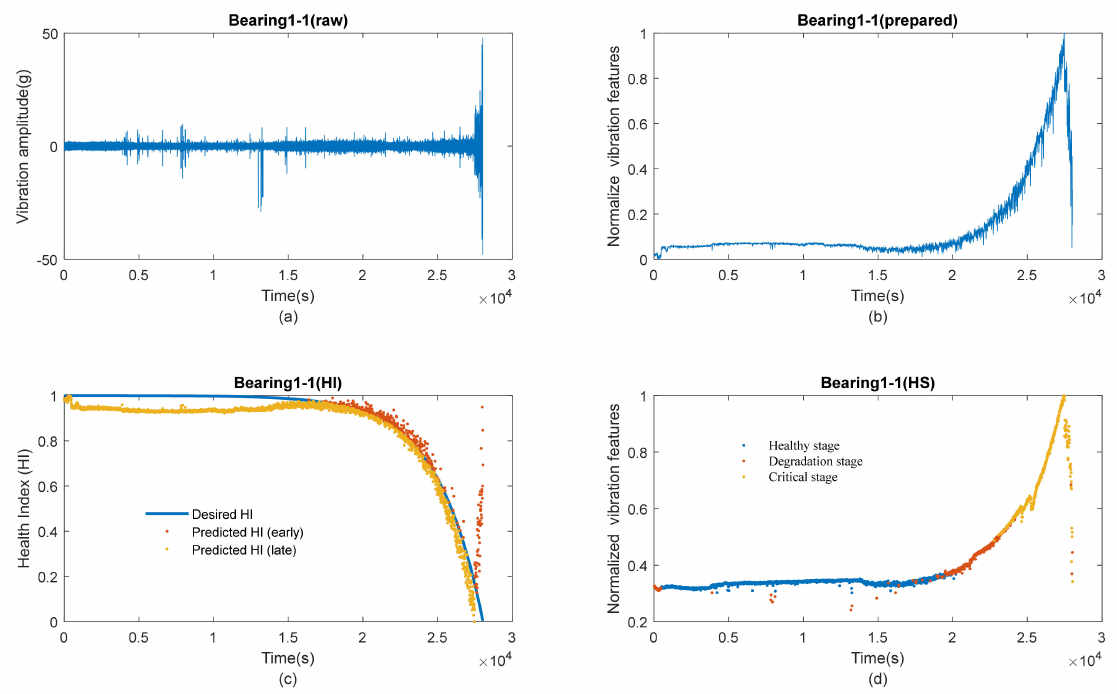
Figure 6. Example of health indicators in a single life cycle from PRONOSTIA dataset (i.e., “Bearing1-1”): ( a ) Raw run-to-failure vibration signal; ( b ) Prepared version of the signal; ( c ) Example of HI identification and curve fitting with a linear model; ( d ) HS divisions with GMM